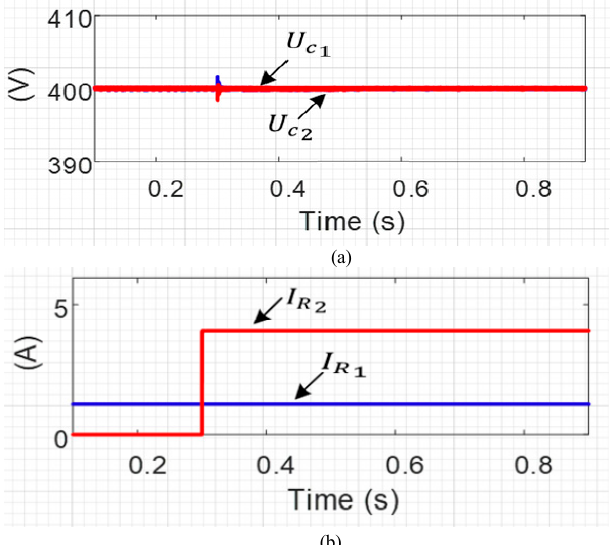
Figure 18. Experimental results under transient load conditions when I R 2 is increasing. ( a ) Output voltages. ( b ) Load currents.